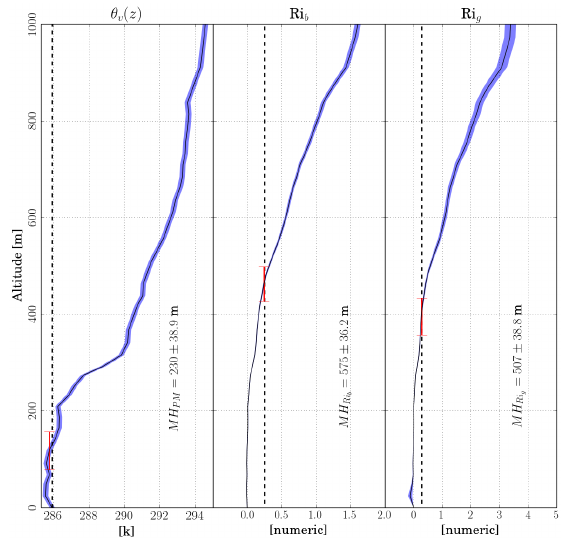
Figure 8. Profiles used for estimating MH on 24 June 2010, 12:00UTC. The θ v , Ri b and Ri g are depicted surrounded by a blue region that represents the error of the profile. The vertical dashed lines represent the threshold that locates the MH. The estimated MH with localization error is shown in red.